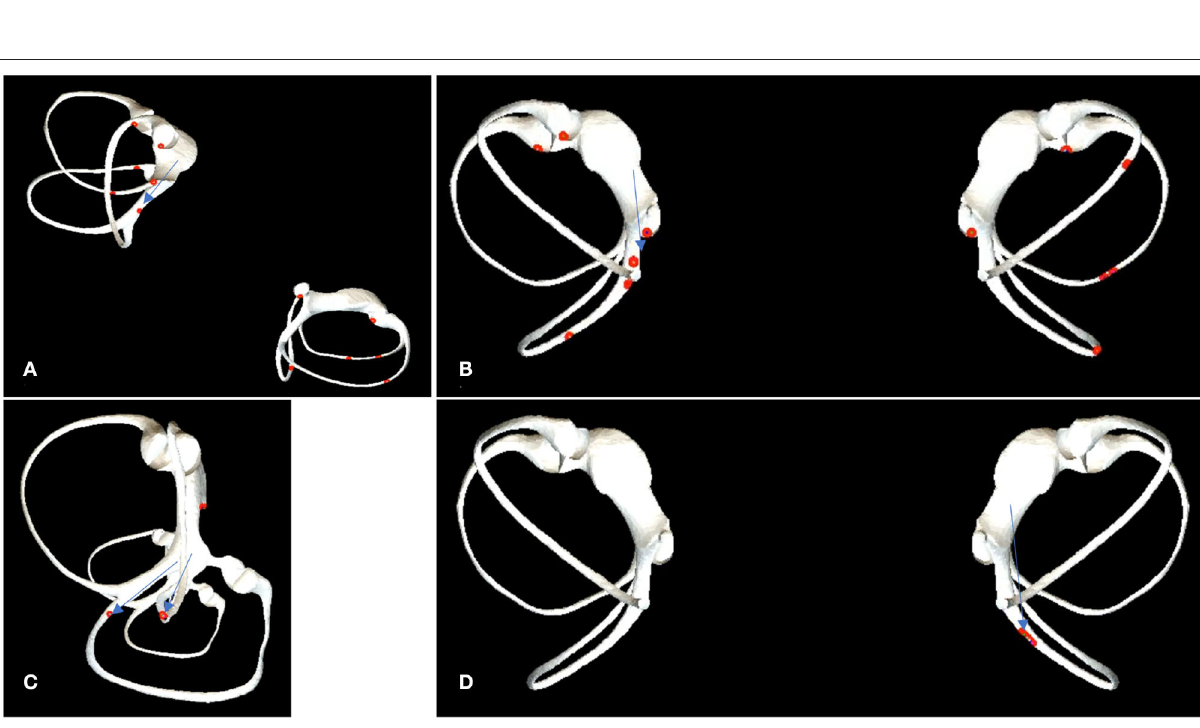
Frontiers in Neurology |